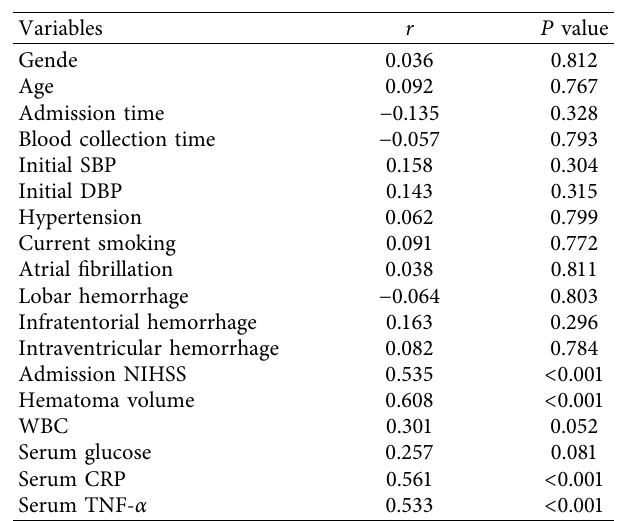
Table 2: Correlation between serum IL-12 levels and other vari- ables using Spearman’s correlation coefficient in ICH patients.